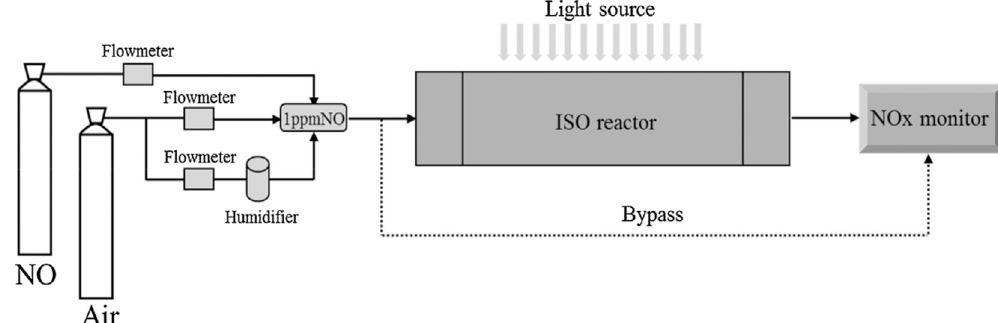
Figure 44. Schematic illustration of photoreactor used in testing the photocatalytic degradation of NO x gases. Reproduced with permission from Yang et al. [132]. Copyright 2018 by The Authors (open access license).